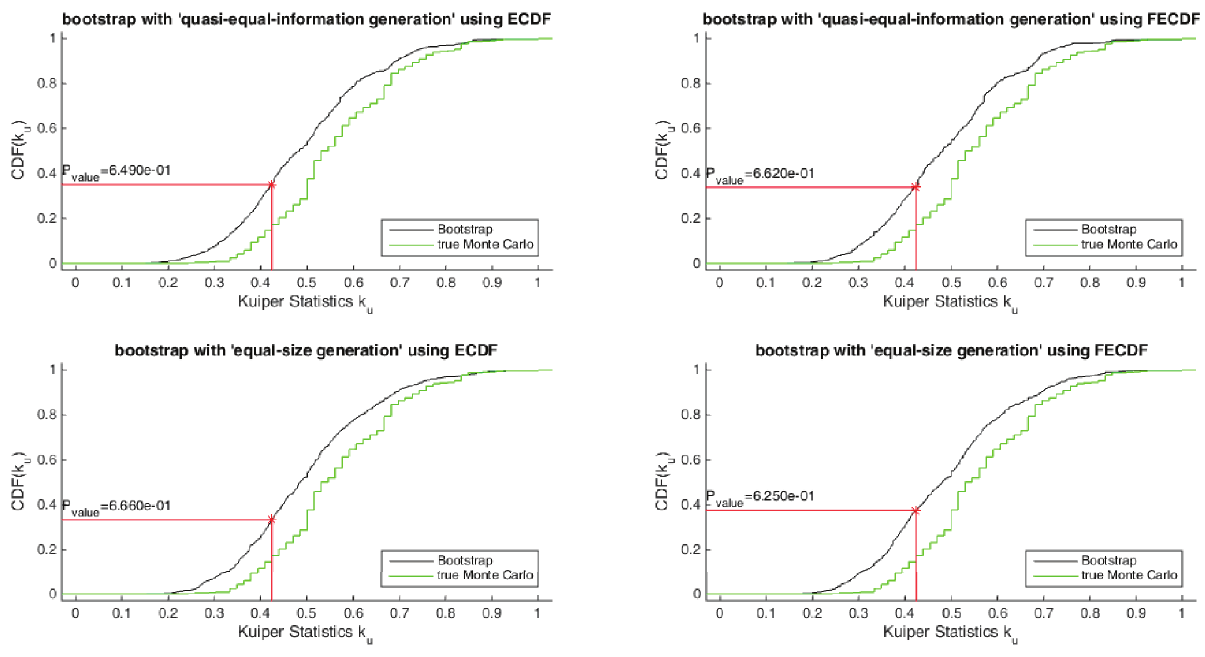
Fig. 5. Bootstrap generated CDFs of the Kuiper's statistic for the fuzzy samples in Numerical example 1, along with the true Monte-Carlo empirical CDF of the same